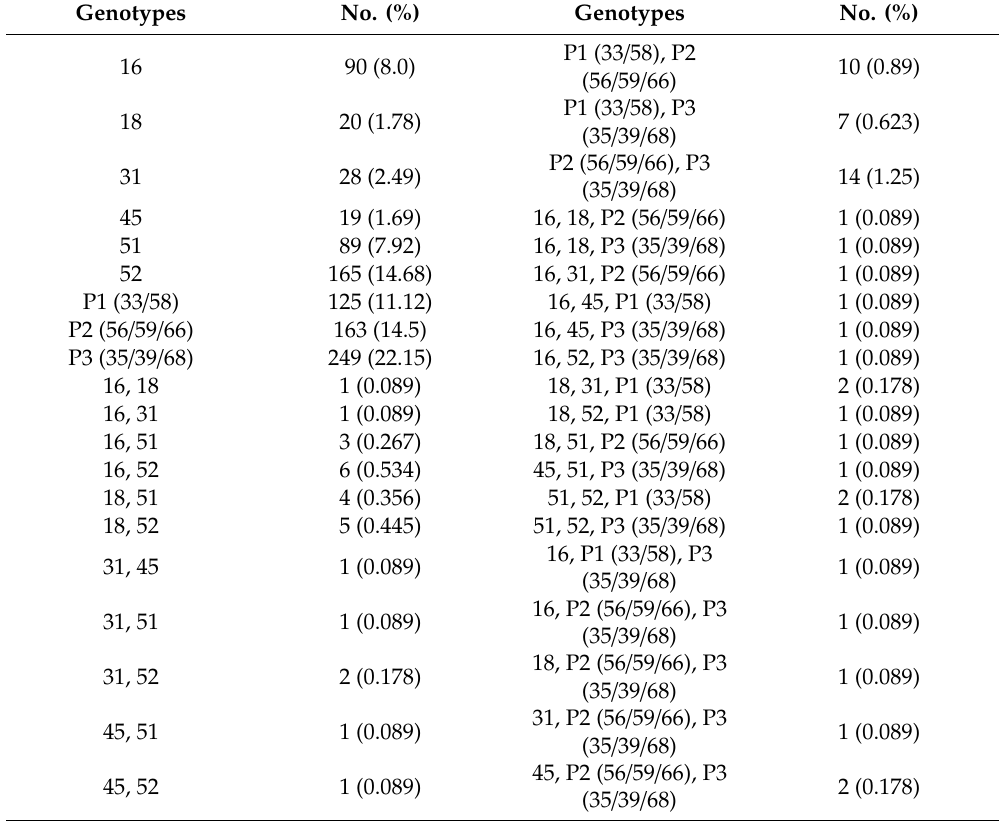
Table 3. HPV genotypes in the BD Onclarity ™ HPV assay